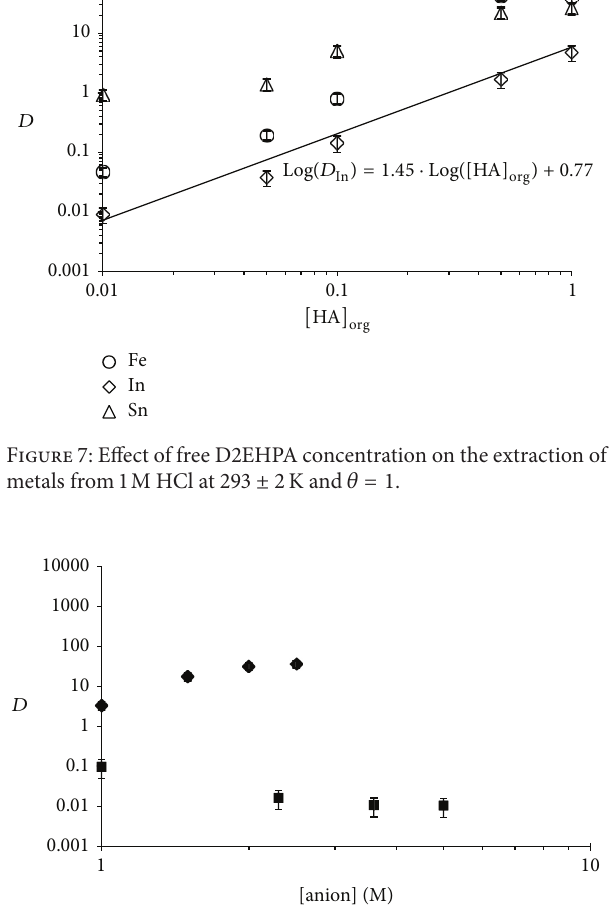
Figure 8: Effect of inorganic anion concentration on the distribu- tion ratio of indium, ( X ) [ SO 42− ] 0.1M D2EHPA/kerosene, [H + ] =